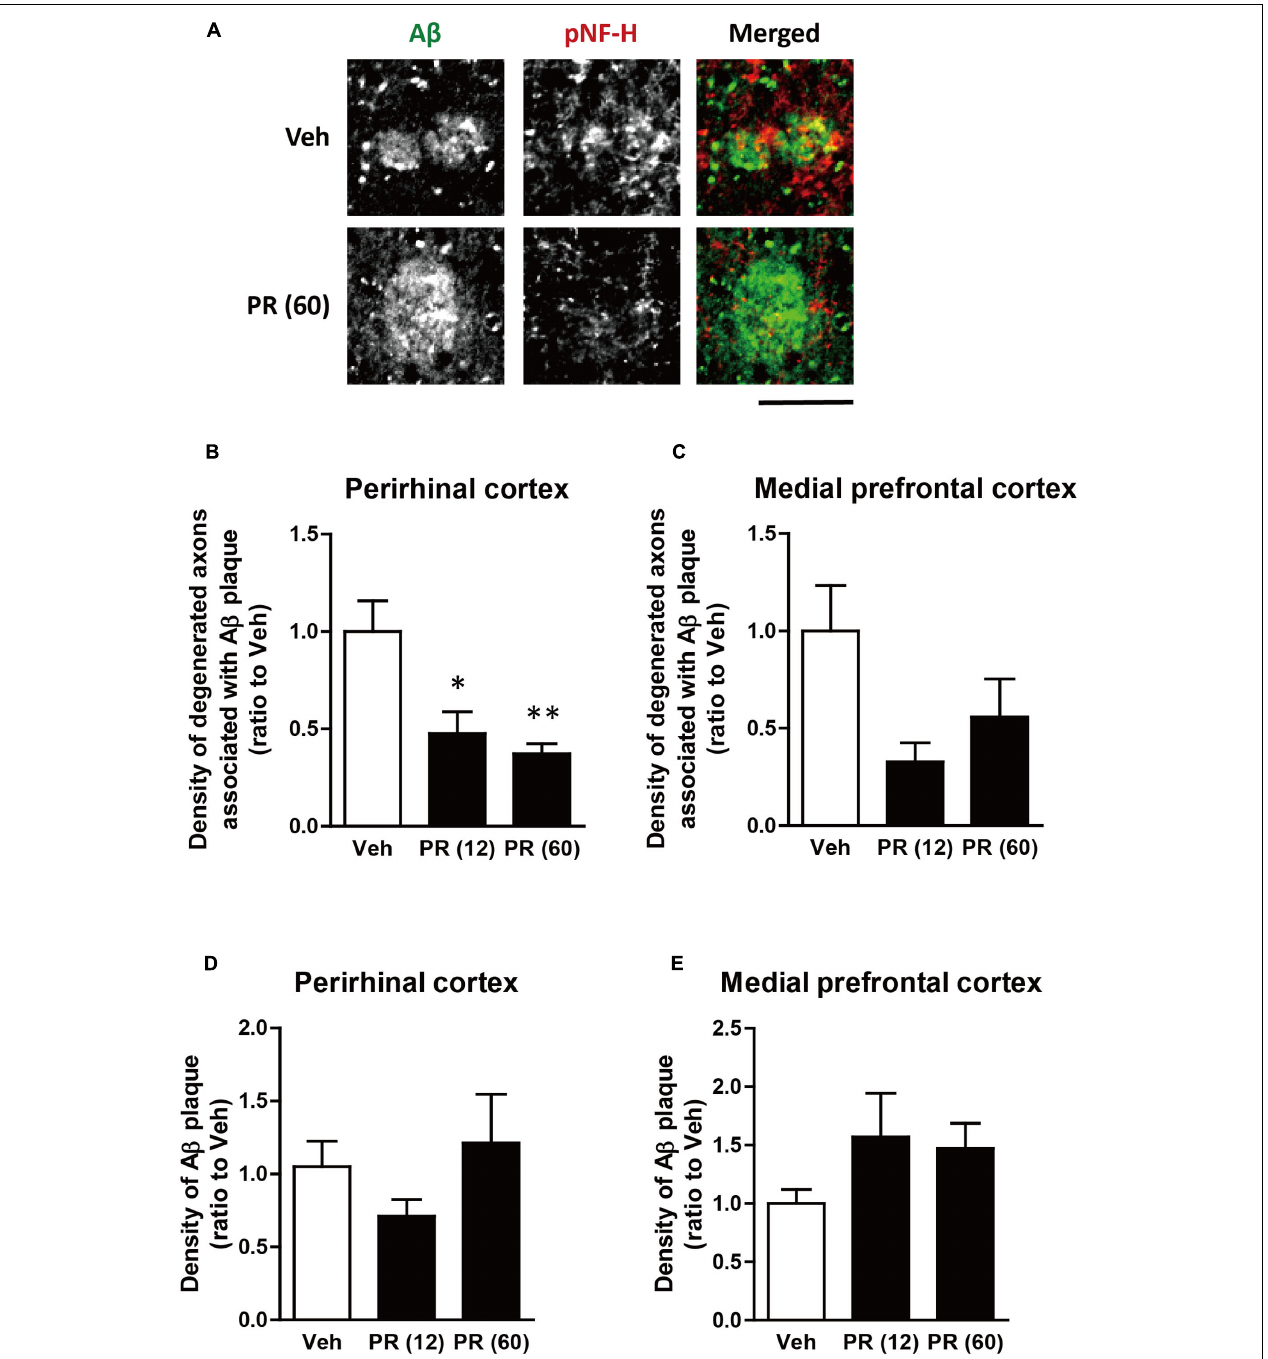
FIGURE 3 | Effects of Polygalae Radix (PR) extract on amyloid β (A β ) plaques and degenerated axons in 5XFAD mice. Vehicle solution (Veh) or PR extract [at doses of 12 or 60 mg kg − 1 day − 1 , PR (12), PR (60), respectively] were orally administered daily for 56 days to 4-month-old wild-type (WT) or 5XFAD mice. The mice were euthanized 2 days after the last administration, and the brains were sectioned and immunostained for phosphorylated neurofilament-H (pNF-H, an axonal marker, red) and A β (green). (A) Representative fluorescence images of the perirhinal cortex are shown. Scale bar, 10 µ m. (B,C) The density of degenerated axons associated with the A β plaques was quantified in the perirhinal cortex (B) and medial prefrontal cortex (C) . (D,E) The density of A β plaques was quantified in the perirhinal cortex (D) and medial prefrontal cortex (E) . The mean values of the data are presented together with the standard error. ∗ P < 0.05, ∗∗ P < 0.01 vs. Veh; Bonferroni’s multiple comparison test, n = 4–5